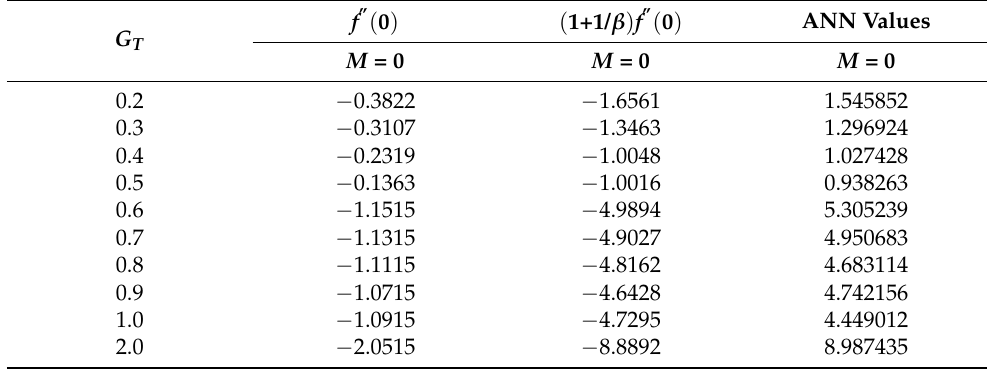
Table 7. Impact of the temperature Grashof number on the SFC for the nonmagnetic flow field.